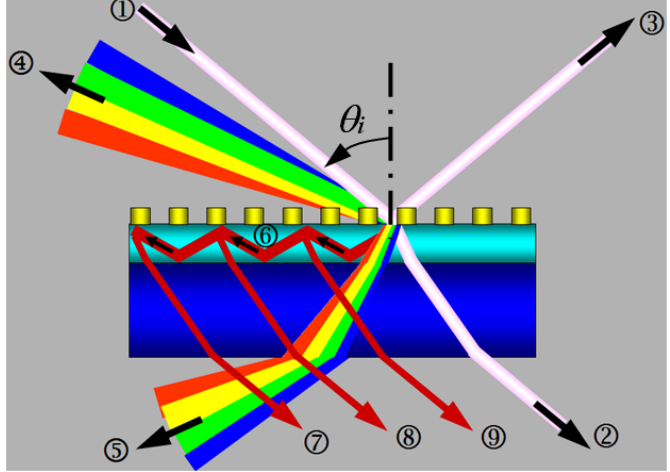
Figure 1. Photophysical processes in waveguide metallic photonic crystals. (cid:99) : incident light beam; (cid:100) : transmitted beam; (cid:101) : reflected beam; (cid:102) : diffraction into the incidence space; (cid:103) : diffraction into the transmission space; (cid:104) : diffraction into the waveguide; (cid:105) , (cid:106) , (cid:107) : secondary diffractions of the waveguide propagation mode by the